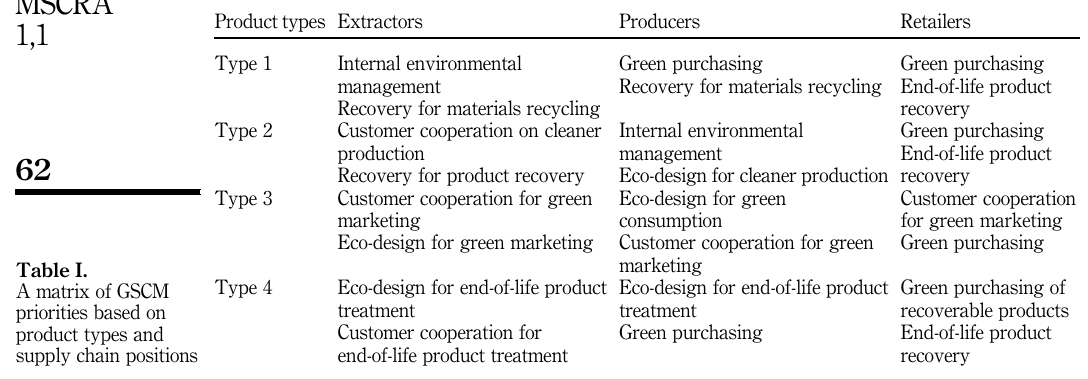
Table I. A matrix of GSCM priorities based on product types and supply chain